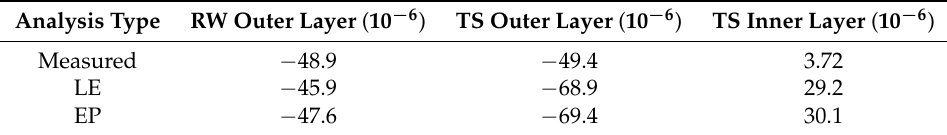
Table 8. Measured and simulated strains of steel rebar, positioned at the inner and the outer reinforcement at midspan of the left cell of the top slab and at the outer reinforcement at the center of the right wall: additional strains, resulting from application of the mechanical loading, considering linear-elastic (LE) or elasto-plastic (EP) material behavior of